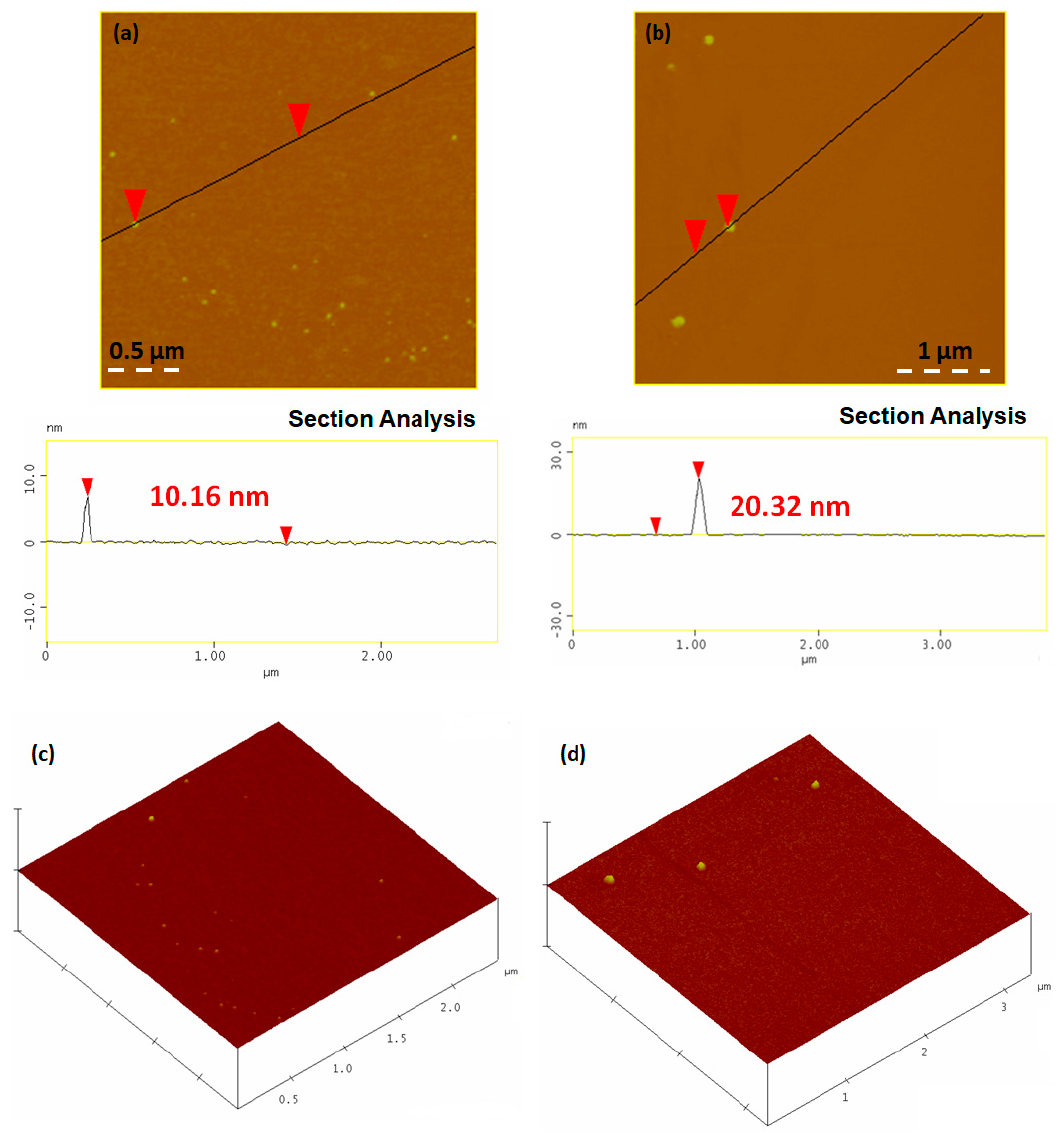
Figure 9. Cross-sectional analysis ( a , b ) and 3D morphology ( c , d ) of the magnetic nanoparticles. ( a , c ) γ -Fe 2 O 3 and ( b , d ) Co.